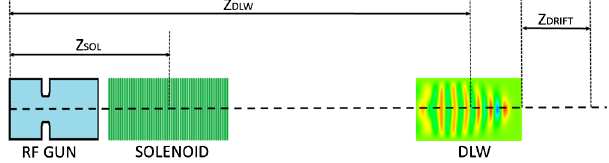
FIG. 4. Overview of the photoinjector setup used for the numerical simulations. The distances Z SOL and Z DLW correspond respectively to the location of the center of the solenoid and DLW structure referenced to the photocathode surface, and Z represents the drift distance downstream of the DLW structure necessary for ballistic bunching.